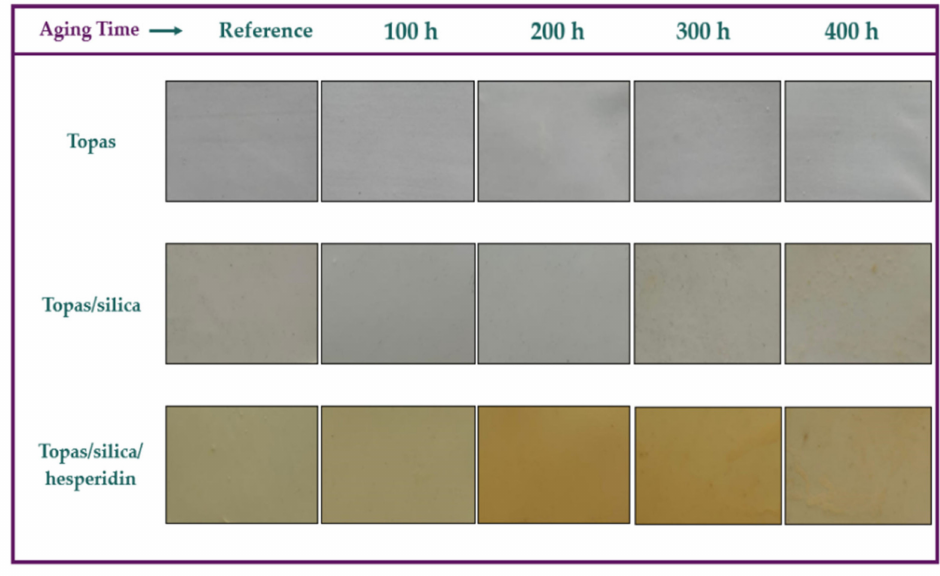
Figure 5. Visual changes in colour of prepared Topas samples induced by weathering aging. Flavonoids (chalcones, anthocyanins, flavones, aurones and flavanols) are chemical compounds that may differ from each other in the location or number of hydroxyl groups, the presence of dimeric structures and the degree of C ring oxidation. What is important, they are able to absorb the visible light in the range of 280–315 nm. However, the bioavail- ability of some flavonoids is limited because of their low solubility in water. For instance, Park [47] stated that α - and β -naphthoflavone (as examples of synthetic flavonoids) exhibit infinitesimal aqueous solubility due to their very low hydroxylation. On the other hand, these natural substances are characterized by good protection against UV radiation, antiox- idant properties, good antibacterial activity and they are responsible for the colouration of fruits and flowers. The color of flavonoids depends on their chemical structure, especially the presence of hydroxyl and methoxyl groups. For example, compounds withnumerous OH groups may display a blue colouration, while OCH 3 groups give these compounds a red colour, and as a result, when added to polymeric materials, they can significantly change the pigmentation of the final product. It was also noted that the characteristic feature of these substances is the colour change with environmental factors